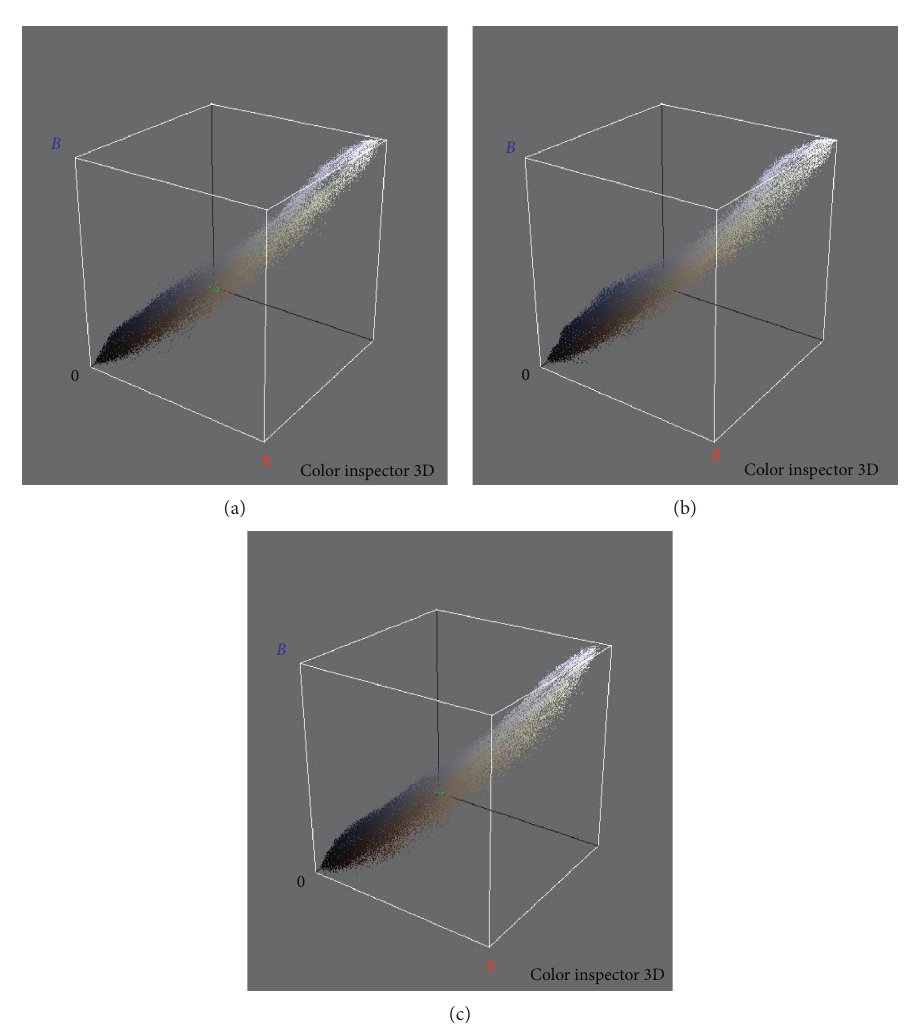
Figure 11: RGB-Model of median filtered. (a) Dry-HP180, (b) 1FT-HO180, (c) 3FT-HP180.